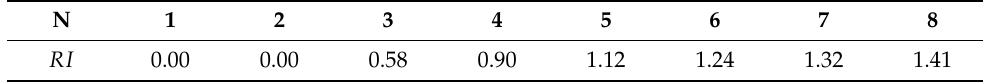
Table 13. Random consistency